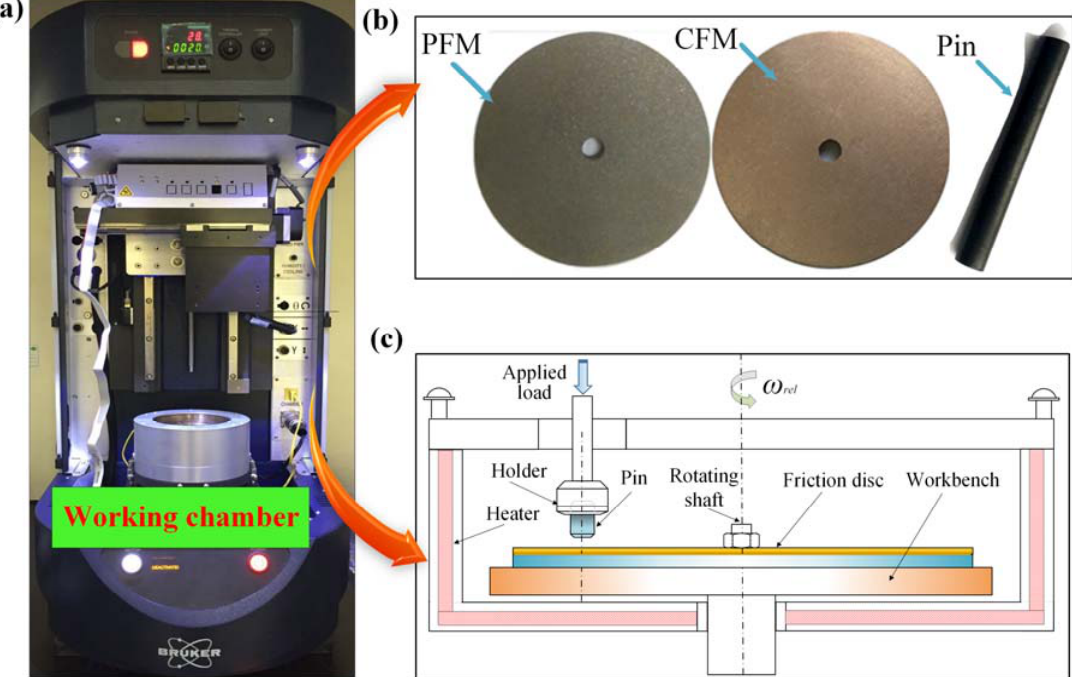
Figure 1. Experimental equipment and test samples ( a ) Universal Material Tester (UMT-5); ( b ) test samples; ( c ) simplified model of the working chamber. Table 1. Experimental conditions.